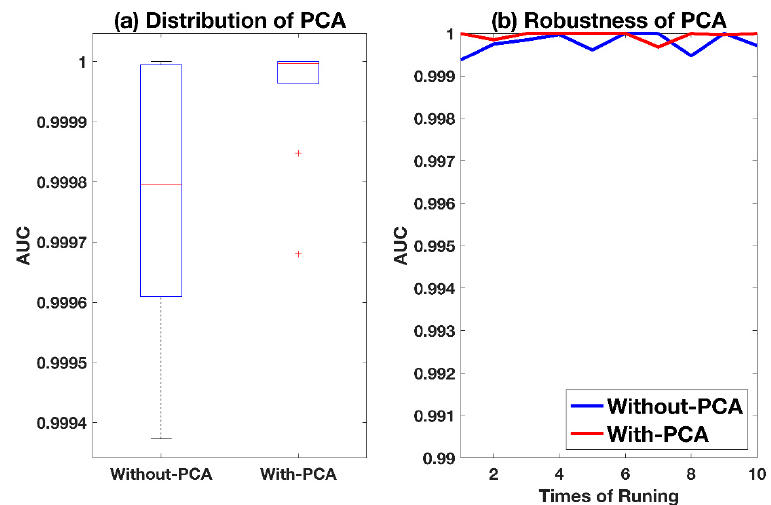
Figure 3. Comparison between different methods for the calculation of the positive center. With-PCA and Without-PCA represent the calculation with and without PCA, respectively. ( a ) Plot of the distribution of the two methods. ( b ) Plot of the trend of the two methods after 10 repetitions.